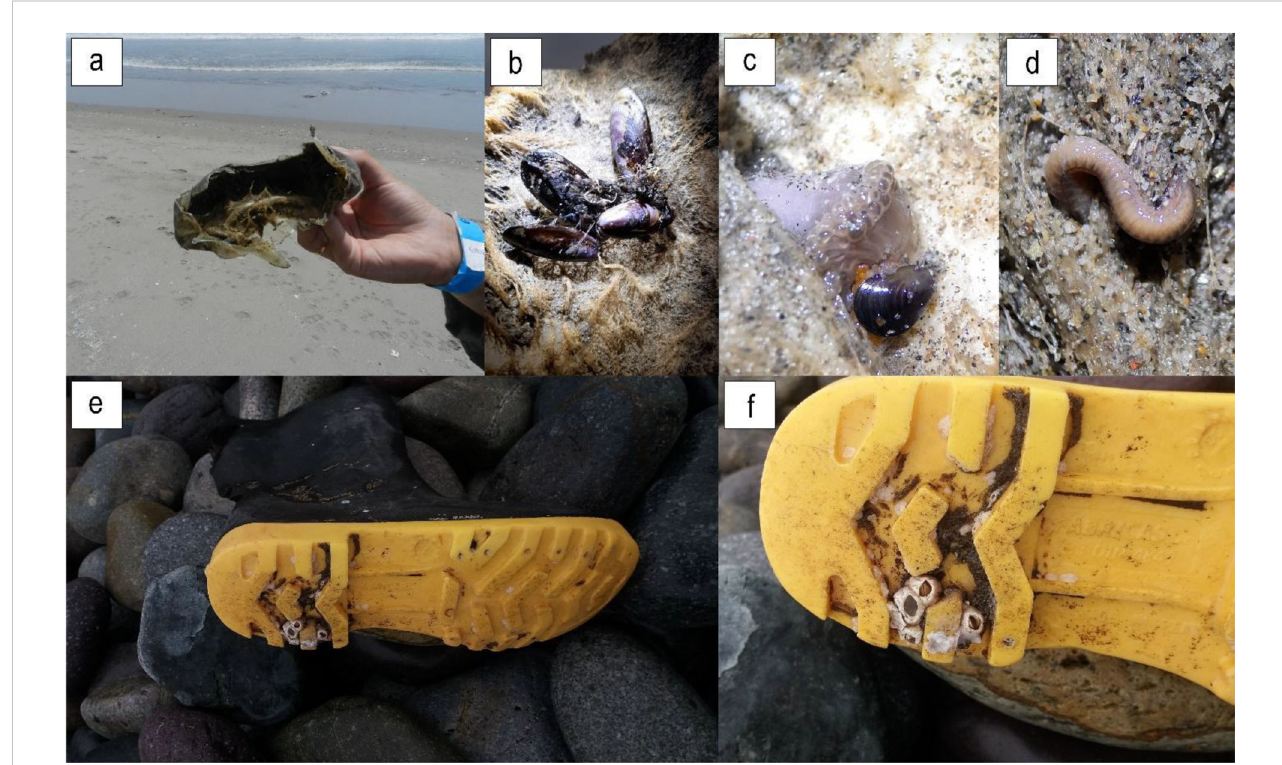
FIGURE 1 Examples of a plastic bottle (A) colonized by the bivalve Semimytilus algosus (B) , anemones (Order: Actiniaria) (C) y bristle worms (Class: Polychaeta) (D) , and a rubber boot (E) colonized by Balanus sp. (F) . (Photographs by